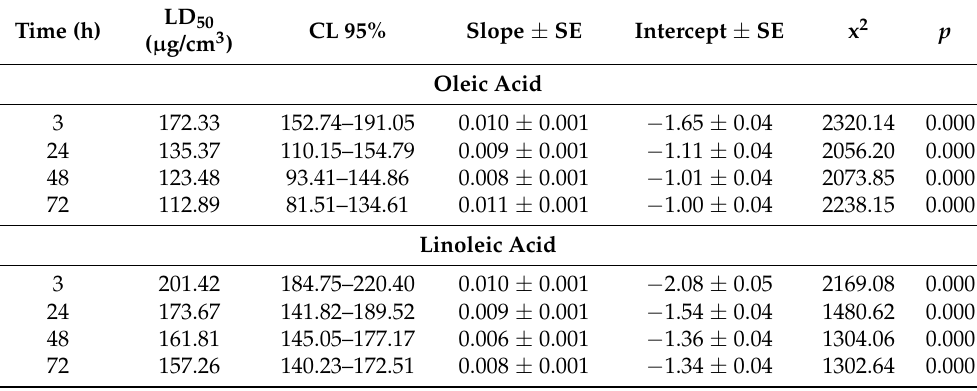
Table 7. Larvicidal activity of oleic and linoleic acid recorded at 3, 24, 48, and 72 h after Petri dish residual exposure bioassay. LD 50 values are considered significantly different when 95% CL fail to overlap. Since goodness-of-fit test is significant ( p < 0.05), a heterogeneity factor is used in the calculation of confidence limits